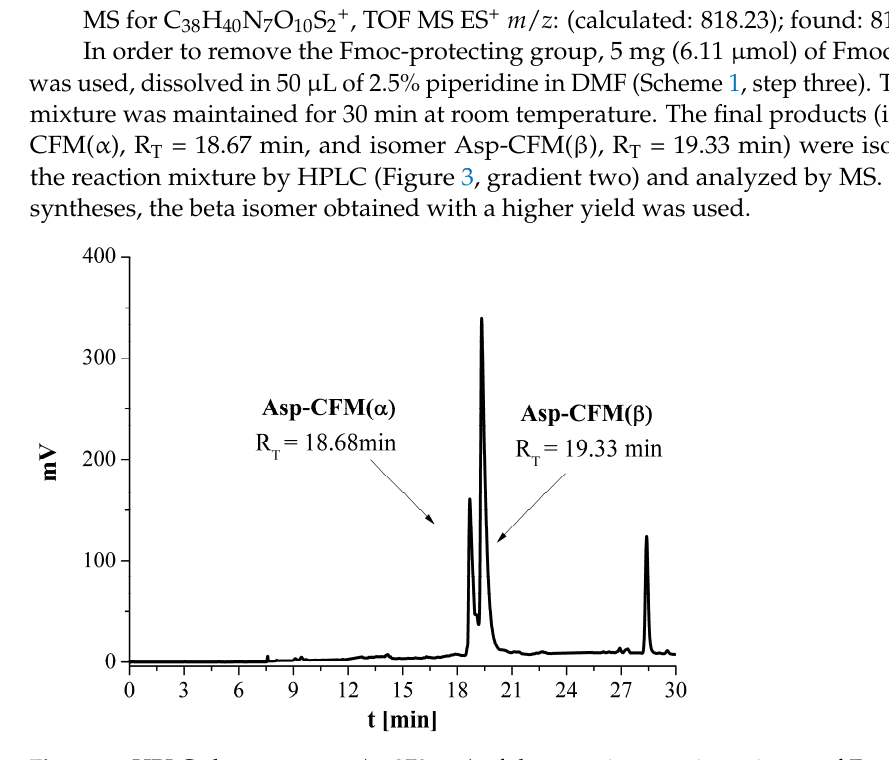
Figure 3. HPLC chromatogram (at 270 nm) of deprotection reaction mixture of Fmoc-Asp-CFM derivative in 2.5% piperidine solution after 30 min; isomer Asp-CFM( α ) with R T = 18.68 min and isomer Asp-CFM( β ) with R T = 19.33 min (gradient 2).